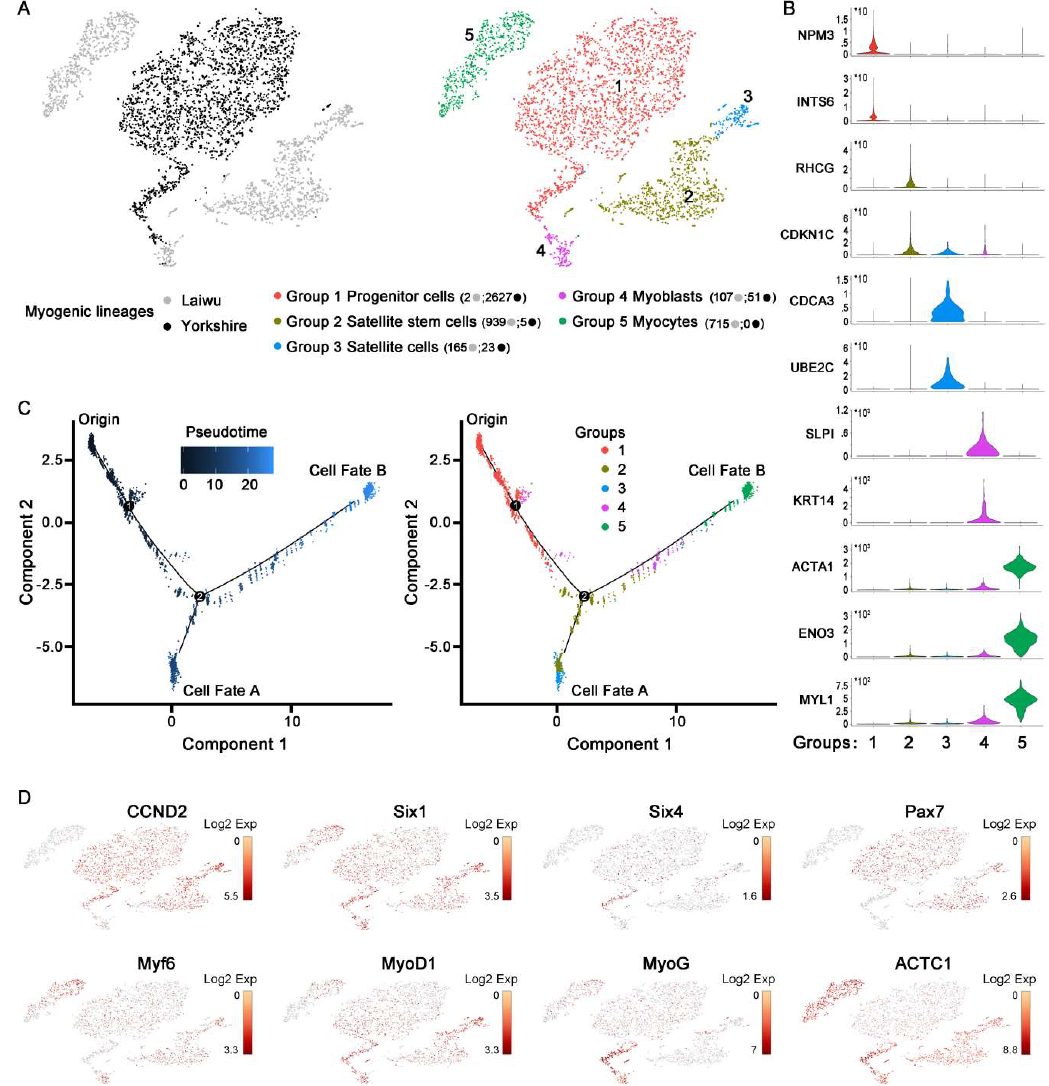
Figure 4. Single-cell RNA expression profiling and cell trajectory analysis delineate the lineage hierarchy of Myo-lineage cells derived from obese- and lean-type pigs. ( A ) Unsupervised clustering of Myo-lineage cells as 3661 from the obese-type pig (Laiwu) and 4257 from the lean-type pig (Yorkshire). ( B ) Violin plots showing the expression levels and distribution of representative marker genes. ( C ) Pseudotemporal cell ordering of Groups 1 to 5 along differentiation trajectories by using Monocle. Pseudotime (arbitrary units) is depicted from dark to light blue (left). Group identities were overlaid on the pseudotime trajectory map (right). ( D ) Individual gene tSNE plots showing the expression levels of genes related to cell differentiation among Myo-lineage cells.